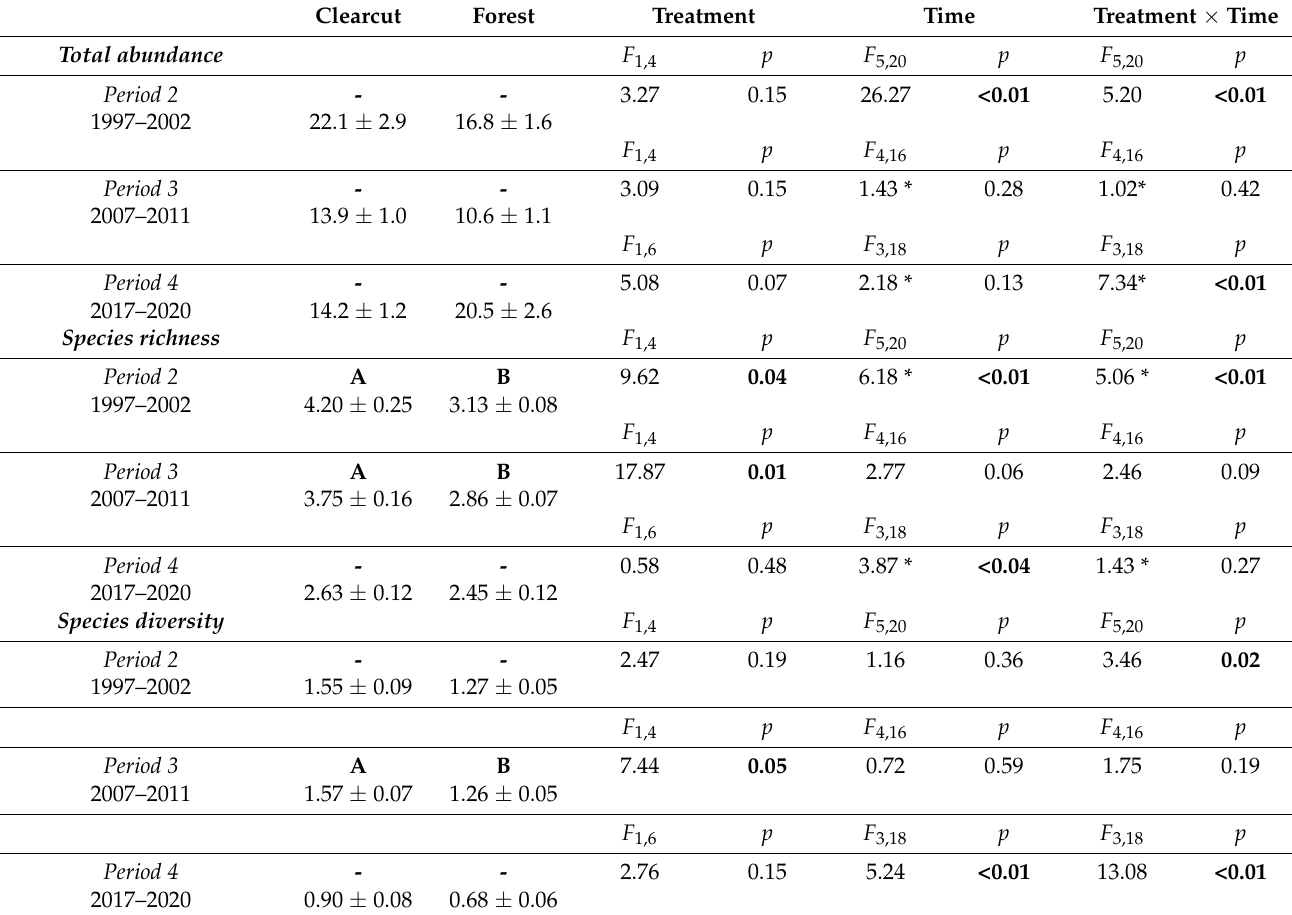
Table 4. Overall mean ( n = 3 × 6; 3 × 5; 4 × 4; sites × years) ± SE annual total abundance, species richness, and species diversity of forest-floor small mammals in clearcut-harvested and forest sites for the CC-FOR study in southern BC, Canada 1997 to 2020, and results of RM-ANOVA for Periods 2 , 3 , and 4 . Within a row, columns of mean values with different letters are significantly different. F -values identified by * were calculated using an H-F correction factor, which decreased the stated degrees of freedom due to correlation among repeated measures. Significant values are given in bold